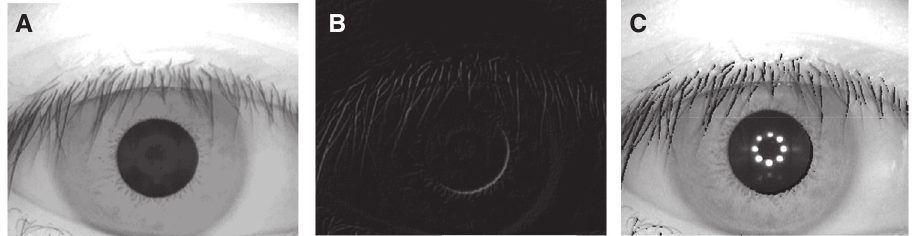
Figure 13. Application of the Diagonal Gradient and the Threshold Method for the Detection of Eyelashes. (A) Corneal reflection removed image. (B) Output of the gradient diagonal. (C) Segmented image by diagonal gradient.